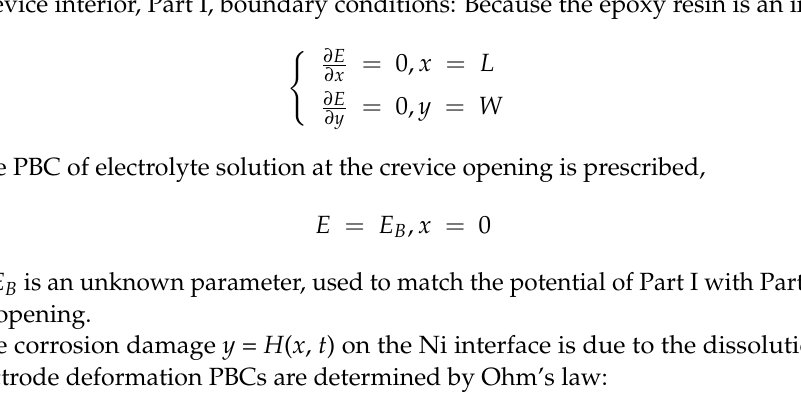
Figure 3. The PBCs of inside and outside the crevice: ( a ) Part I; ( b ) Part II. Crevice interior, Part I, boundary conditions: Because the epoxy resin is an